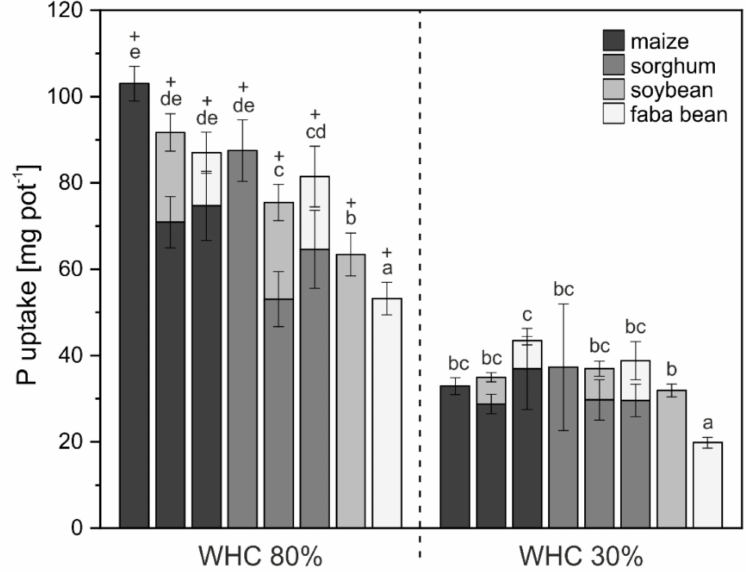
Figure 3. E ff ect of water supply on phosphorus uptake of the crops and mixtures in the Water-Trial (mean ± SD). Di ff erent letters indicate significant di ff erences between the crop variants at each water level, + indicates di ff erences between the water levels (ANOVA and Duncan’s test, p ≤ 0.05). WHC = water holding